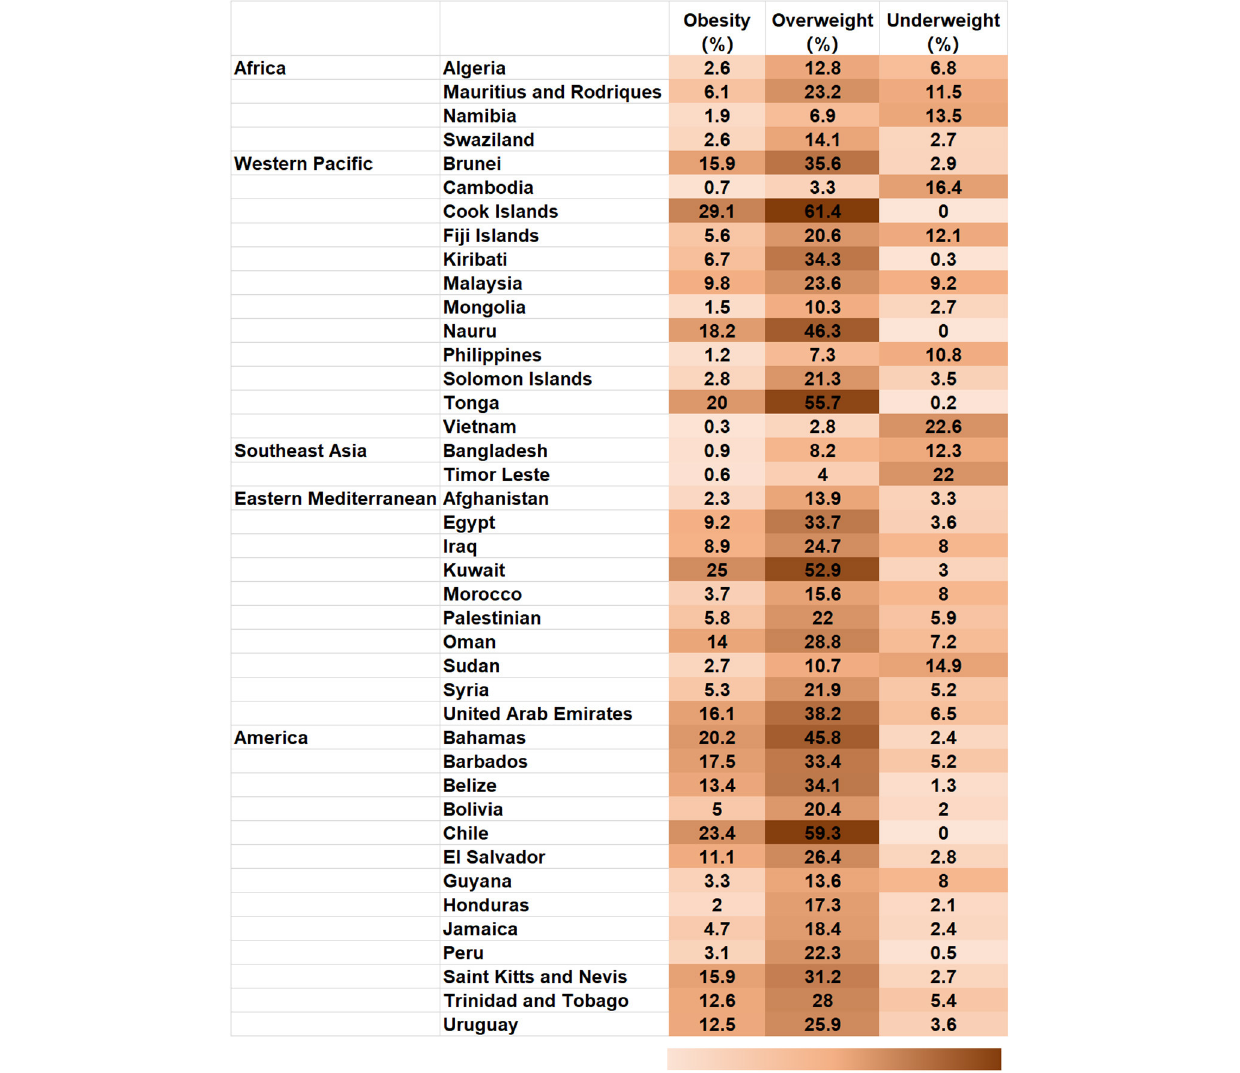
aged 12–13 and 14–15 years, as indicated by non-overlapping 95%